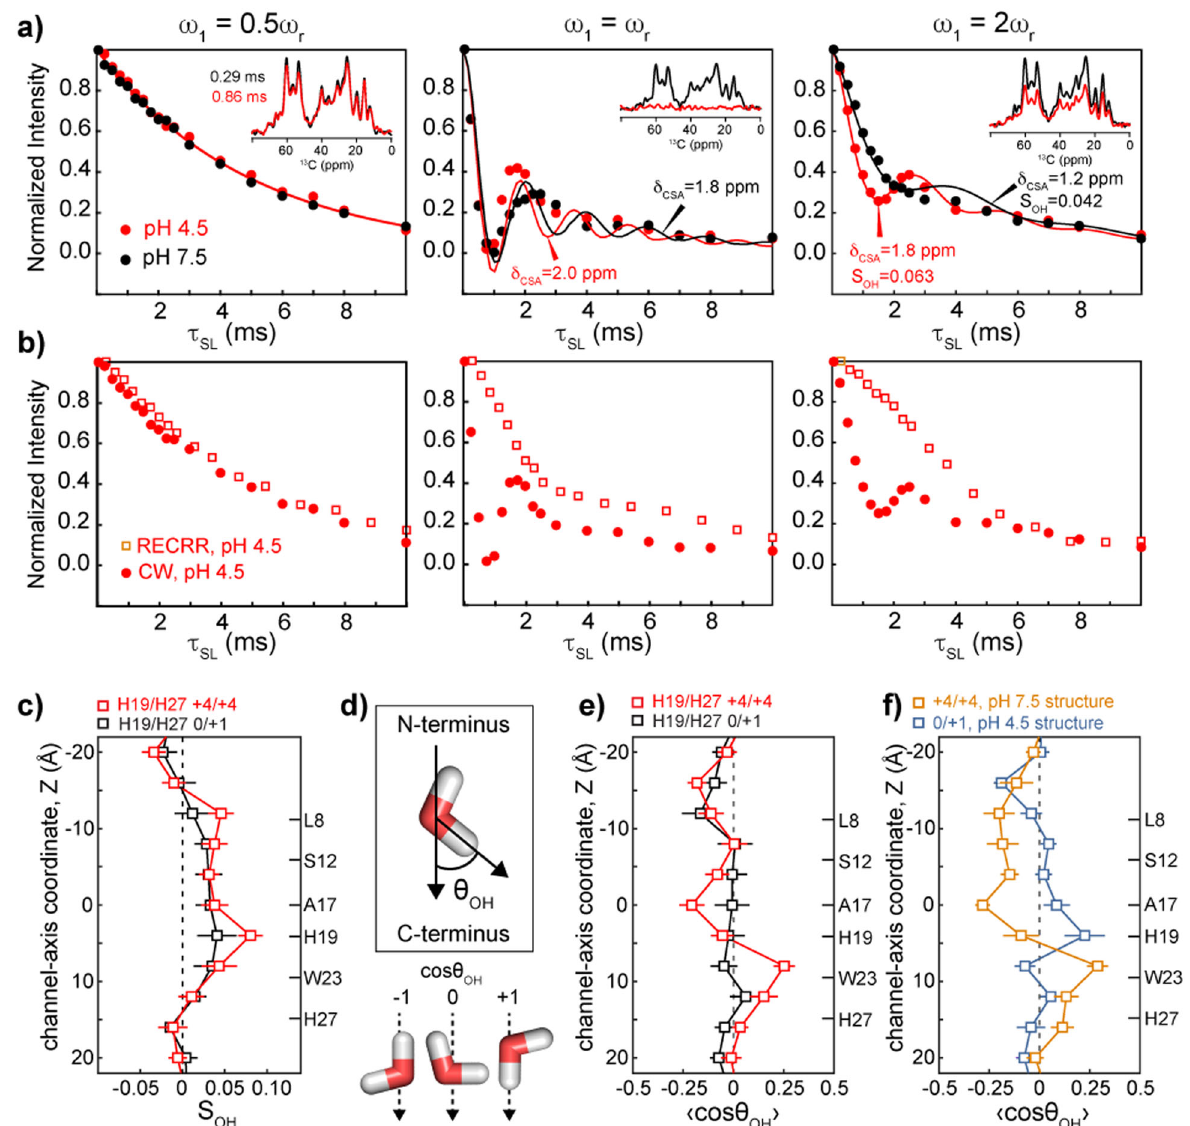
Fig. 5 Channel-water orientational order in BM2 from 13 C-detected 1 H spin-lock recoupling NMR experiments and MD simulations. a 13 C-detected water 1 H spin-lock recoupling data at ω 1 = 0.5 ω r (left), ω r (middle) and 2 ω r (right). The spectral region integrated for each data point is shown in the inset for representative spin-lock times. Coherent oscillations are observed at ω r and 2 ω r but not at 0.5 ω r , indicating that 1 H CSA is the dominant anisotropic interaction. b Comparison of 13 C-detected water 1 H RECRR data (open squares) and CW spin-lock recoupling data ( fi lled circles) at the three recoupling conditions. The oscillations are mostly removed by RECRR. c Simulated water OH-bond order parameter, S OH , in the open and closed BM2 channels. d De fi nition of θ OH and representative water orientations for cos θ OH values of − 1, 0, and 1. Positive cos θ OH corresponds to water oxygen pointing to the N-terminus. e Time-averaged water cos θ OH values. Water has larger anisotropy in the open + 4/ + 4 channel than in the closed 0/ + 1 channel. An orientation change is observed at residue A17 at low pH. f Time-averaged cos θ OH of channel water when the + 4/ + 4 state is restrained to the high-pH solid-state NMR protein structure (PDB: 6PVR) and the 0/ + 1 state is restrained to the low-pH solid-state NMR structure (PDB: 6PVT). Positive <cos θ OH > near W23 and negative <cos θ OH > near L8 are observed for the + 4/ + 4 state despite the high-pH structure. Error bars for simulations are the standard error of the mean for four independent